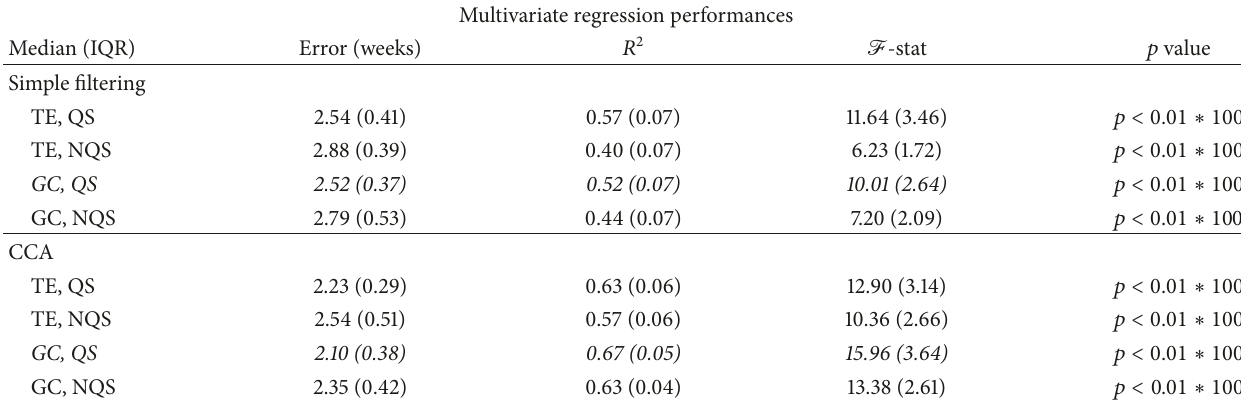
Table 4: Multivariate regression model performances. The table shows the error on the test set (Error), 𝑅 2 and the 𝐹 -statistics ( F -stat), and the 𝑝 value obtained with the different connectivity methods in the different sleep states. The results are reported as median (IQR), where IQR stands for InterQuartile Range over the 100 random splits of the dataset. The labels reported are TE = transfer entropy, GC = Granger causality, QS = quiet sleep, and NQS = nonquiet